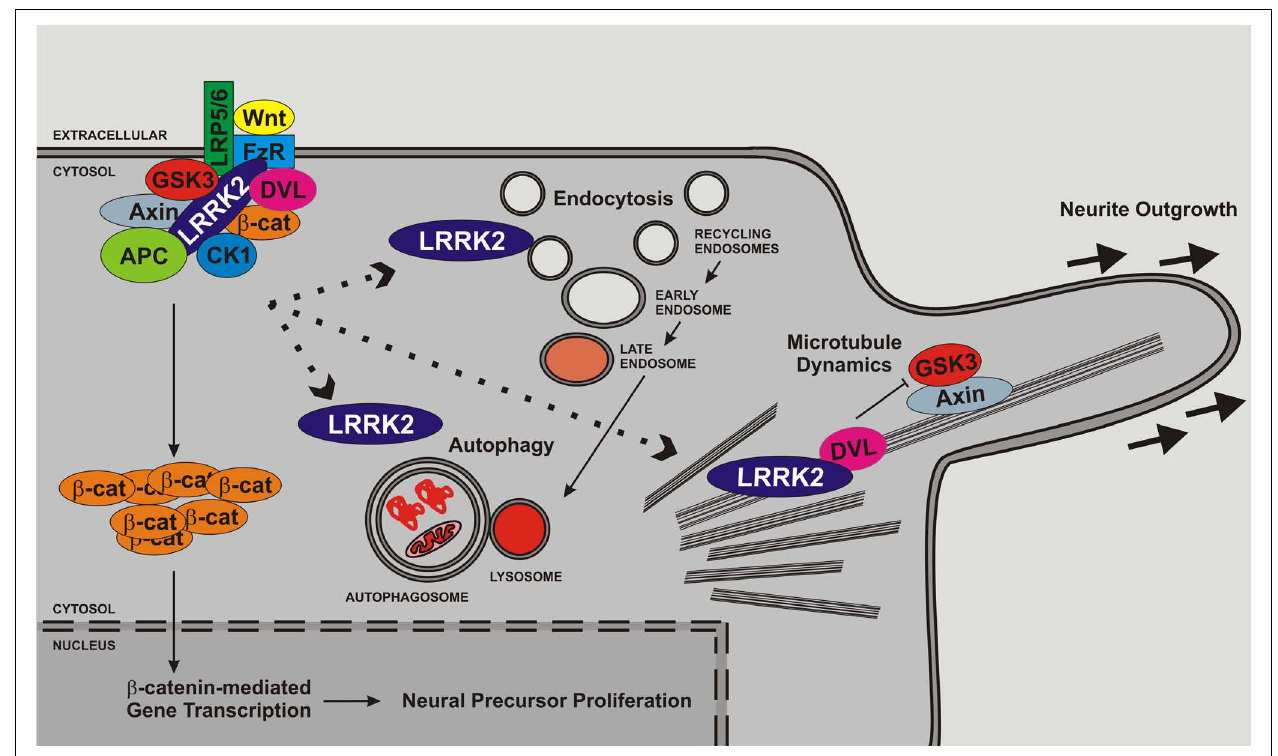
FIGURE 2 | LRRK2 regulates cell biological functions important for neurogenesis. Several lines of evidence support roles for LRRK2 in microtubule function, endocytosis/vesicle trafficking and autophagy. LRRK2 is likely to impact upon neurite outgrowth and the latter stages of neurogenesis through direct association with membrane structures and microtubules and/or